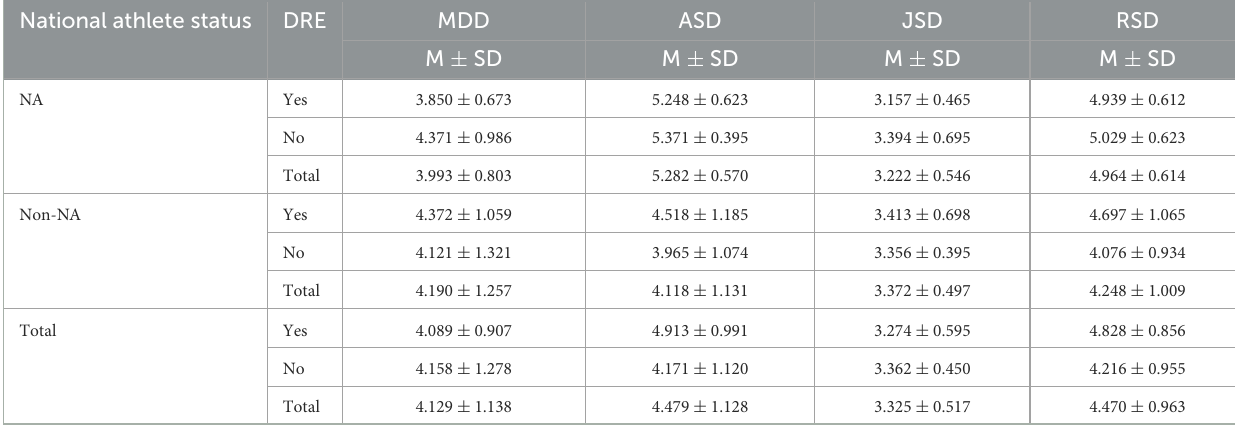
TABLE 2 Descriptive statistics of MDD, ASD, JSD, and RSD scores for NA and DRE groups. National athlete status